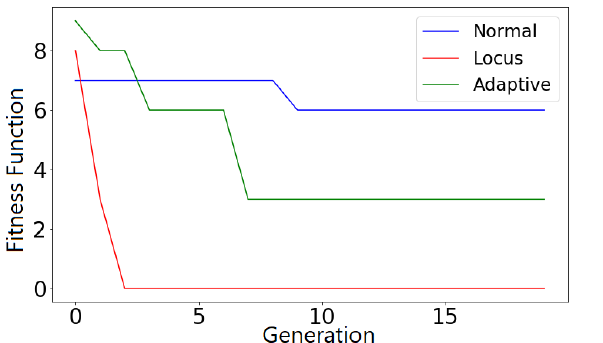
Figure 6. The fitness value of 64-Queens problem as a function of the number of generations comparing locus mutation with traditional and adaptive mutation. For adaptive mutation, We have averaged out 30 different ranges and used the center of each range for traditional and locus mutation. All the experiments have been repeated 10 times with the same set of parameters. Although we have used the mean solution for locus mutation, we have selected the best solution for adaptive and traditional